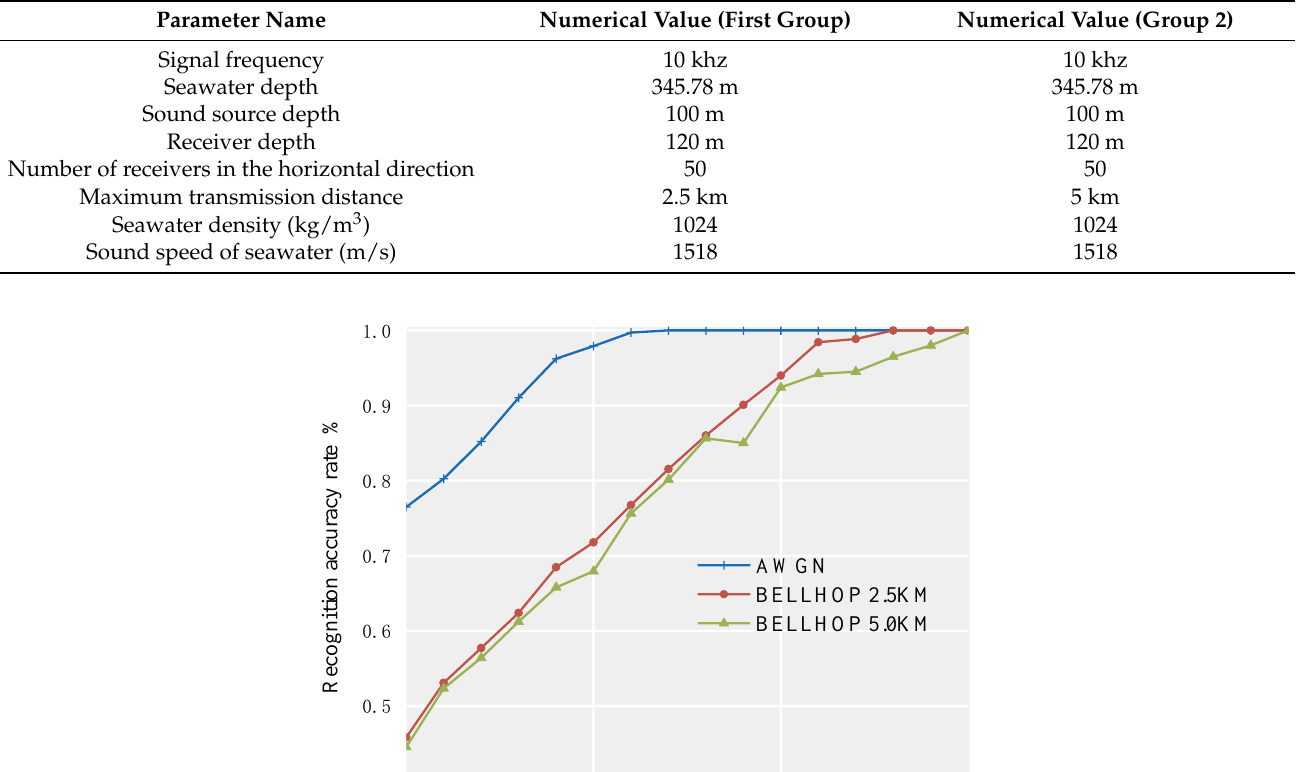
Figure 9. Accuracy of each signal identification under 2.5 km transmission superposition model of BELLHOP channel. Table 2. BELLHOP channel parameters. Table 2. BELLHOP channel parameters.